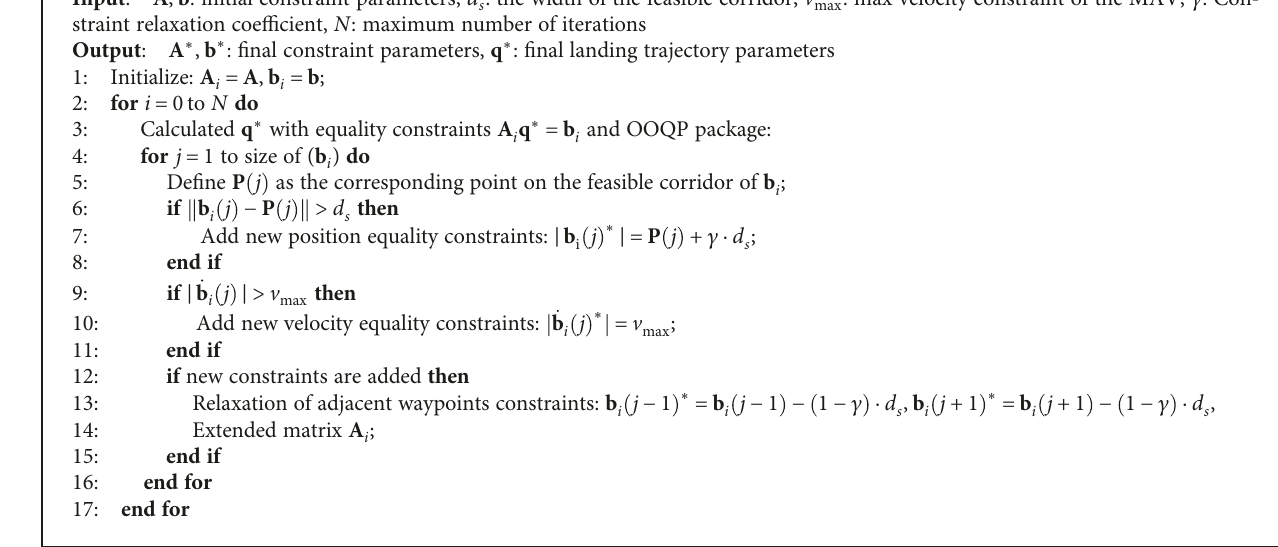
Algorithm 1: IAEC